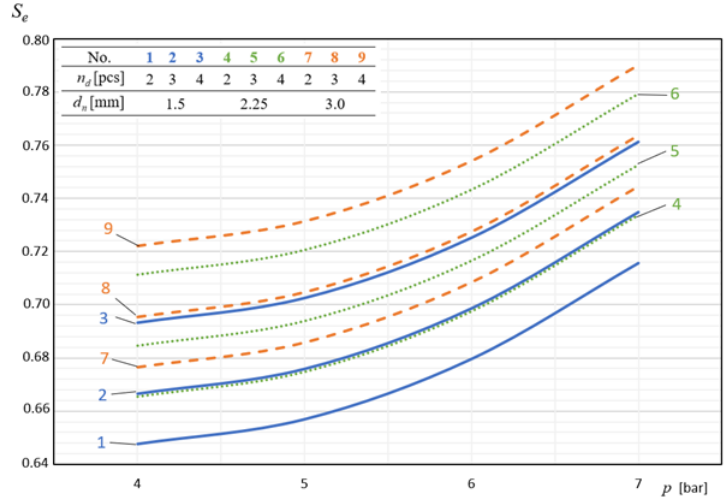
Figure 13. Influence of the air pressure supplying the nozzles removing the scales on the effectiveness of the machine’s operation at constant parameters 𝑣 𝑝 = 60 pcs./min and 𝑑 𝑛 = 1.5 mm. We could not refer to the results of research available in the literature due to the lack of articles on the subjects of onion cutting and their surface layers.